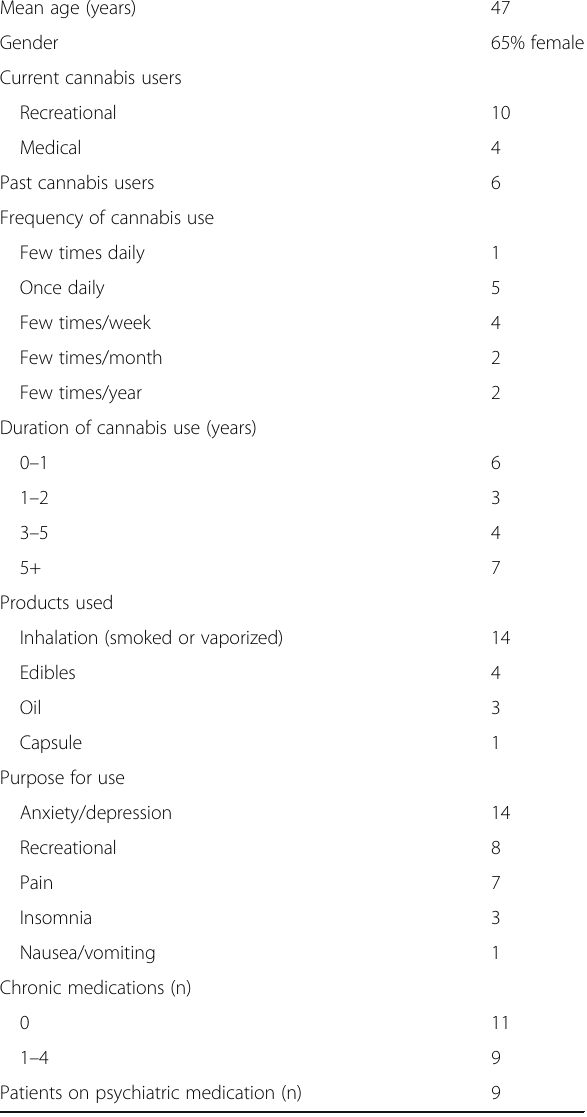
Table 1 Cannabis use history of 20 medical cannabis patients in Toronto,